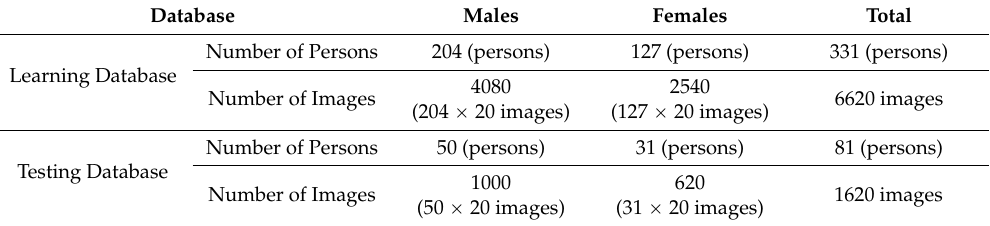
Table 3. Detailed description of learning and testing sub-databases used in our